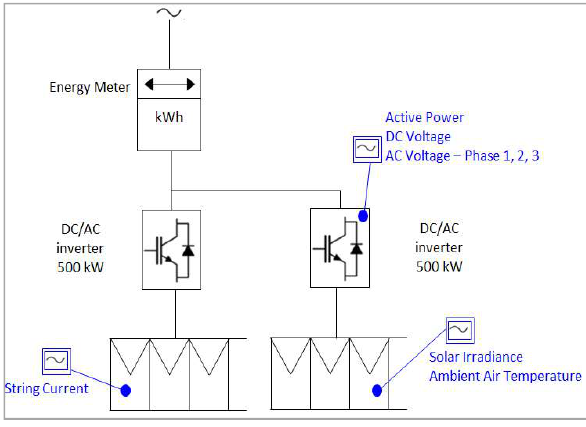
Figure 1. Schematic block circuit diagram of the PV system with sensors and measuring points.